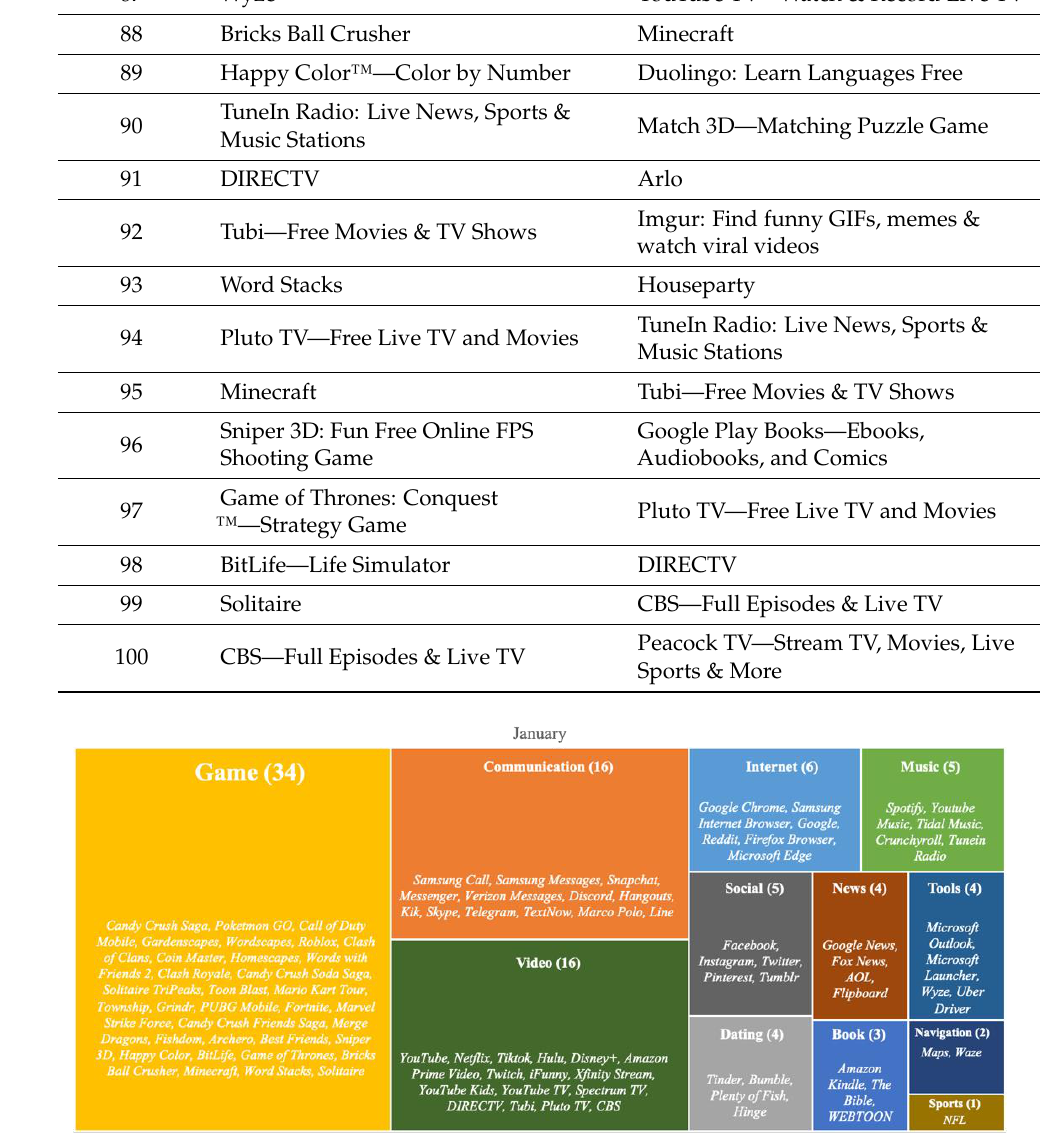
Figure 2. Process of creating a persona.